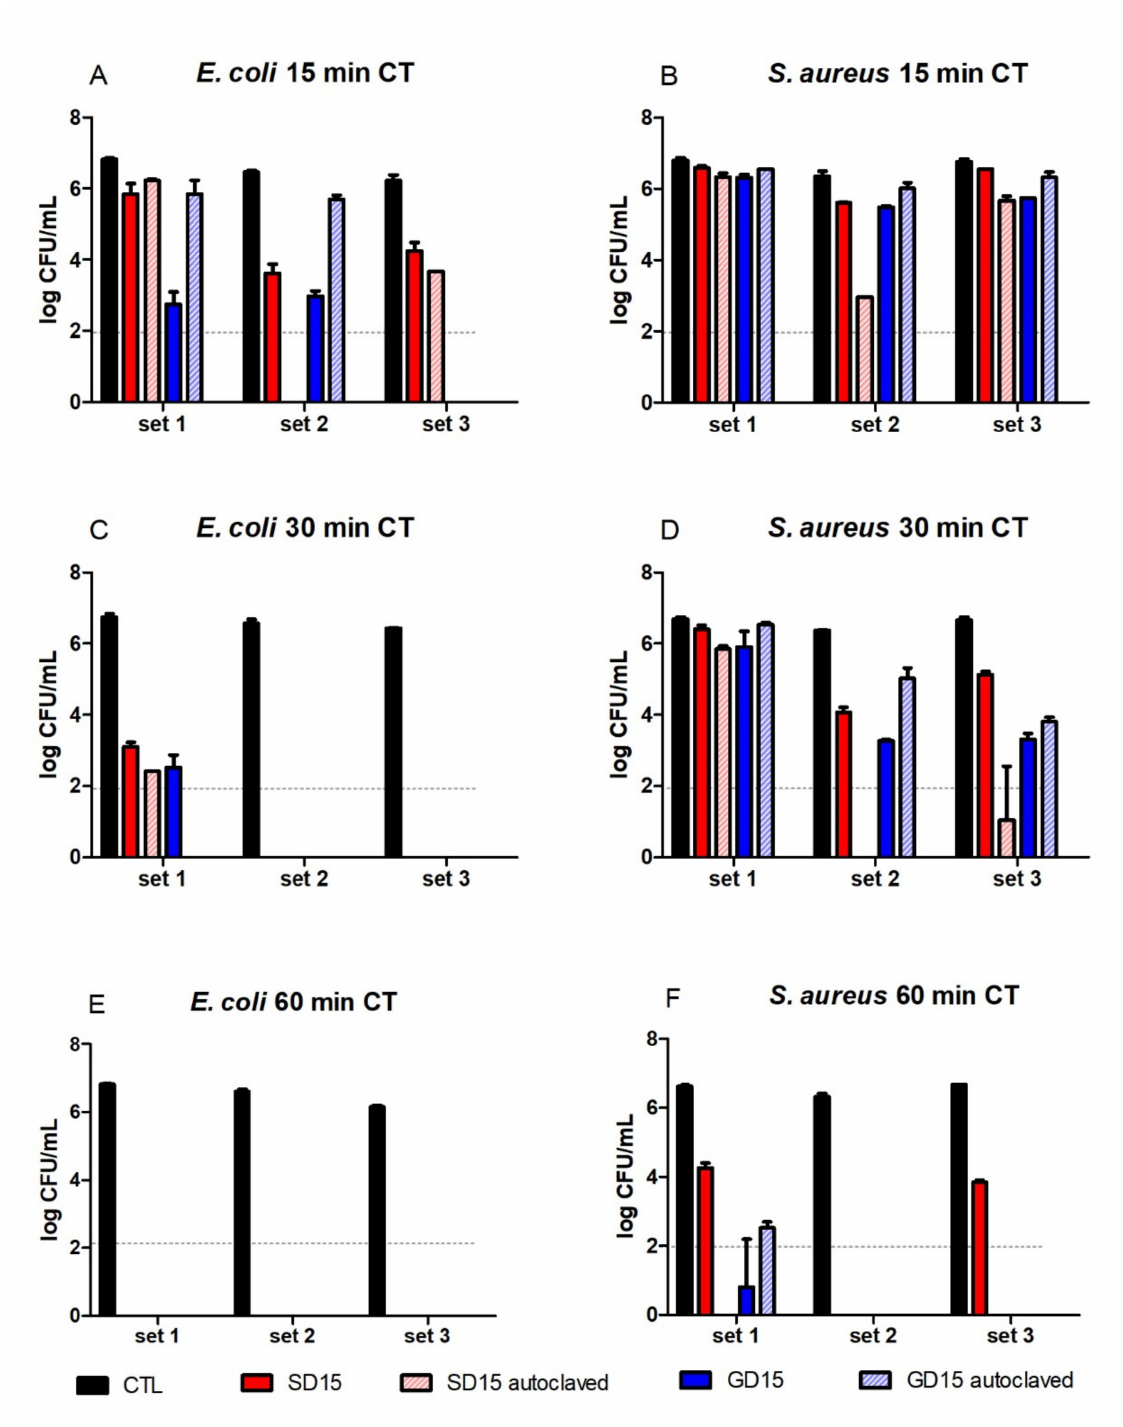
Figure 6. Effect of autoclaving on retention of antimicrobial activity of SD15 and GD15 PAW over 15–60 min contact time (CT). ( A ) E. coli —15 min; ( B ) S. aureus —15 min; ( C ) E. coli —30 min; ( D ) S. aureus —30 min; ( E ) E. coli —60 min; ( F ) S. aureus —60 min (data shown as mean ± SD). Limit of detection: 2 log 10